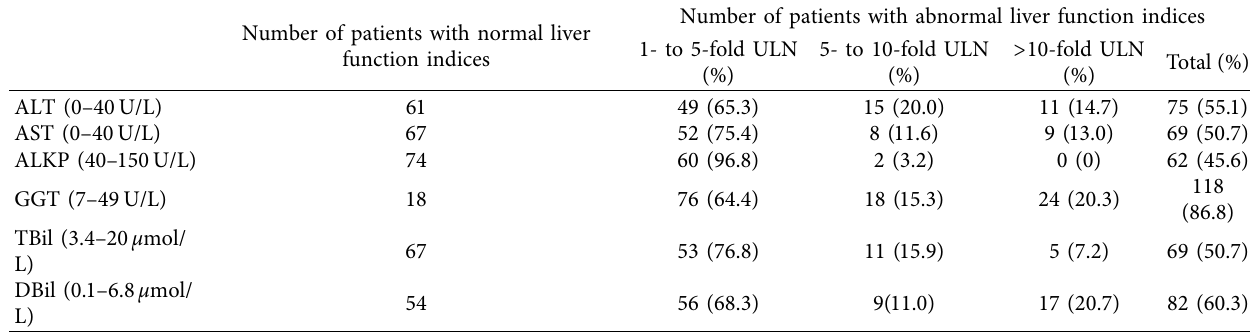
Table 1: Abnormal liver function indices of 136 patients with elevated serum IgG4.